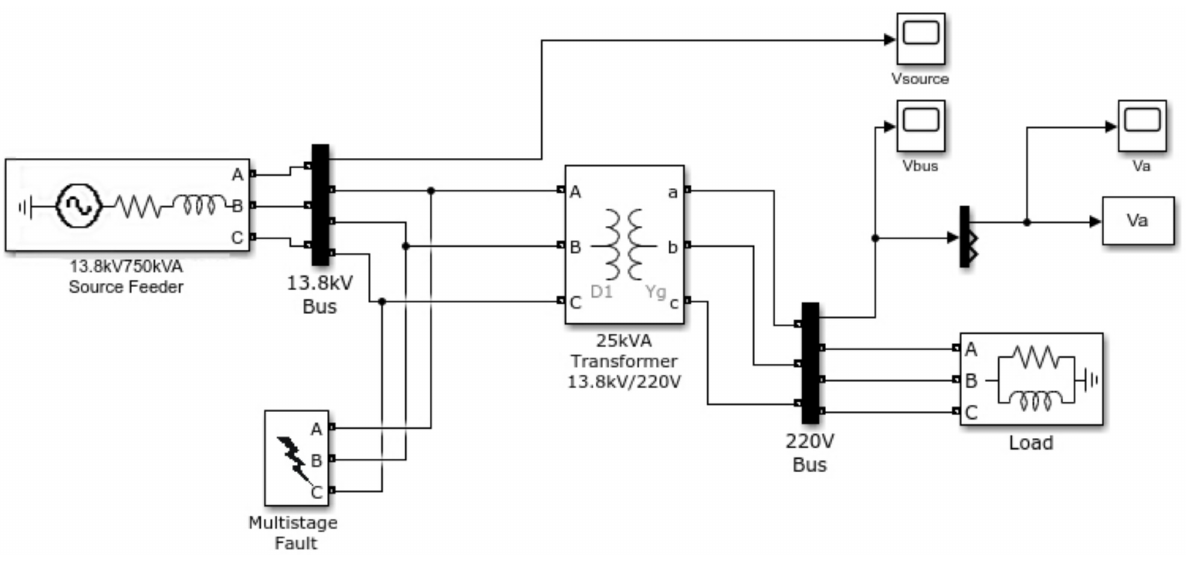
Figure 6. MATLAB/Simulink model for simulated short-duration voltage